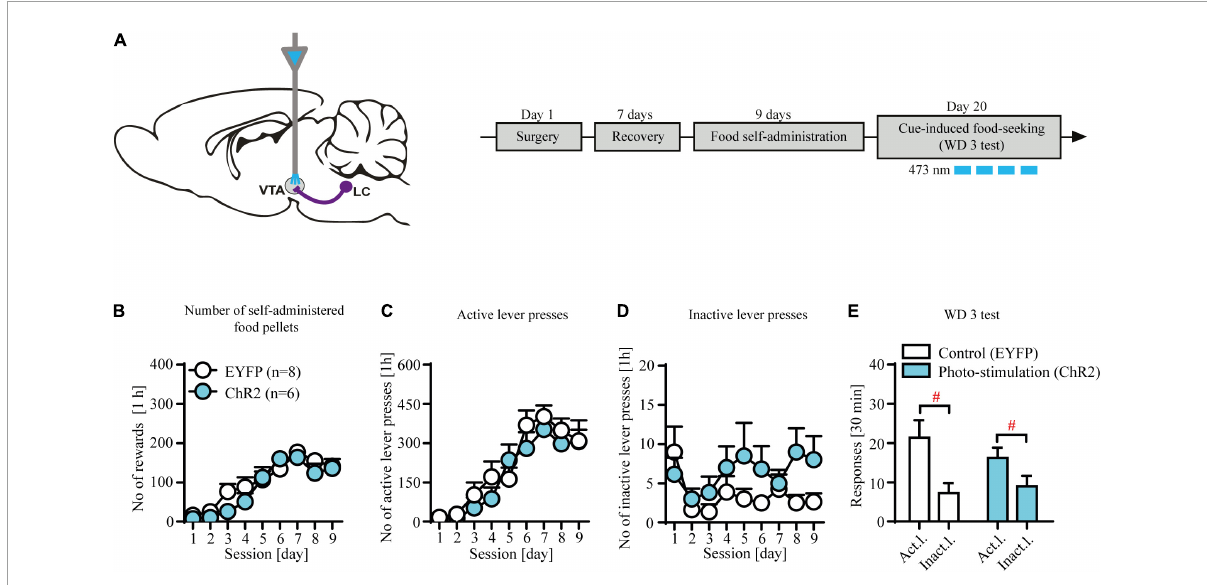
FIGURE3 Contingent photo-stimulation of locus coeruleus (LC) noradrenergic efferents in ventral tegmental area (VTA) has no effects on food-seeking. (A) The scheme of the photo-modulation of the VTA afferents from the LC and the experimental time-line: rats, after intra-LC viral microinjections and intra-VTA optical fiber implantations and recovery were trained to self-administer food pellet (45-mg) for 9 days (1 h/day), after which they underwent forced abstinence for 3 days. On withdrawal 3 (WD 3), rats were tested for food seeking with brief, contingent photo-stimulation (473 nm, 360 × 10 ms pulses at 60 Hz) where active lever presses led to the presentation of CS without food delivery. (B) There were no differences in the number of self-administered food pellets or (C) , (D) lever responses during food self-administration in future contingent photo-stimulation groups. (E) Contingent photo-stimulation of LC noradrenergic efferents in VTA did not affect performance during WD 3 test, as both ChR2-expressing group and control group did not differ in levers responding (lever F ( 1 , 24 ) = 14.7, p < 0.001; followed by post hoc test p < 0.01; treatment × lever: n.s.; treatment: n.s.). Data are presented as the mean ± SEM. Act. l.: active lever; Inact. l.: inactive lever. # p < 0.05; n.s. not